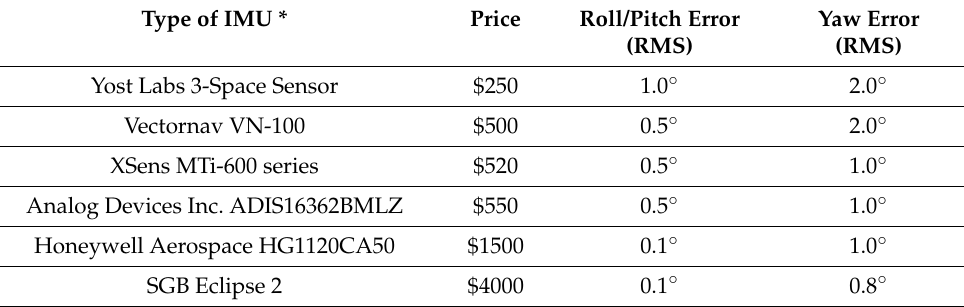
Table 1. Orientation performance specification of popular IMU used in drones. Type of IMU * Price Roll/Pitch Error Yaw Error (RMS) (RMS) Yost Labs 3-Space